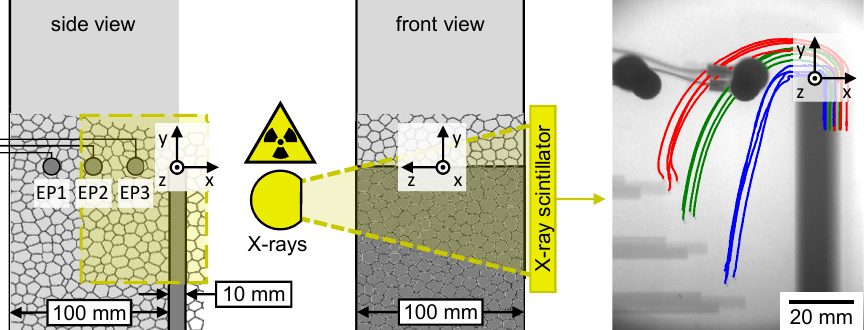
Figure 1. Overflowing foam is imaged in a laboratory-scale experiment by means of X-ray radio- graphic measurements employing customised tracer particles. Local flow velocities are determined using X-ray particle tracking velocimetry. Near the weir, the liquid fraction of the foam is monitored by measuring its electric conductivity between three different electrode pairs (EP1, EP2, EP3). The red, green and blue lines highlighted in the X-ray image on the right indicate the motion paths of three different tracer particles, particularly their radiopaque